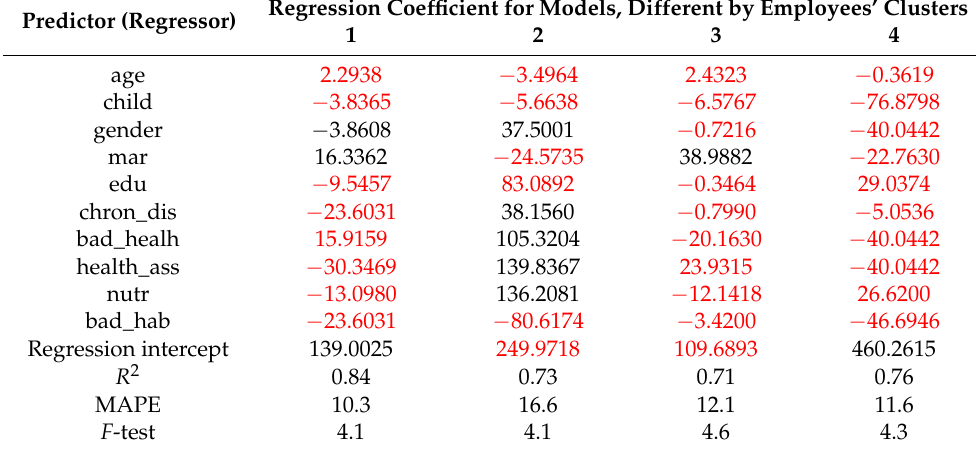
Table 7. Regression results by employees’ clusters (significant parameters are marked in red). Regression Coefficient for Models, Different by Employees’ Predictor (Regressor)